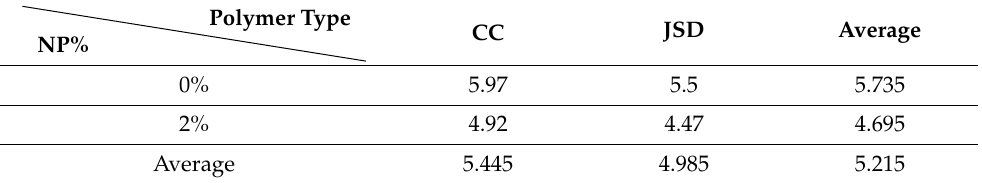
Table 5. The effect of NP% on recovery speed